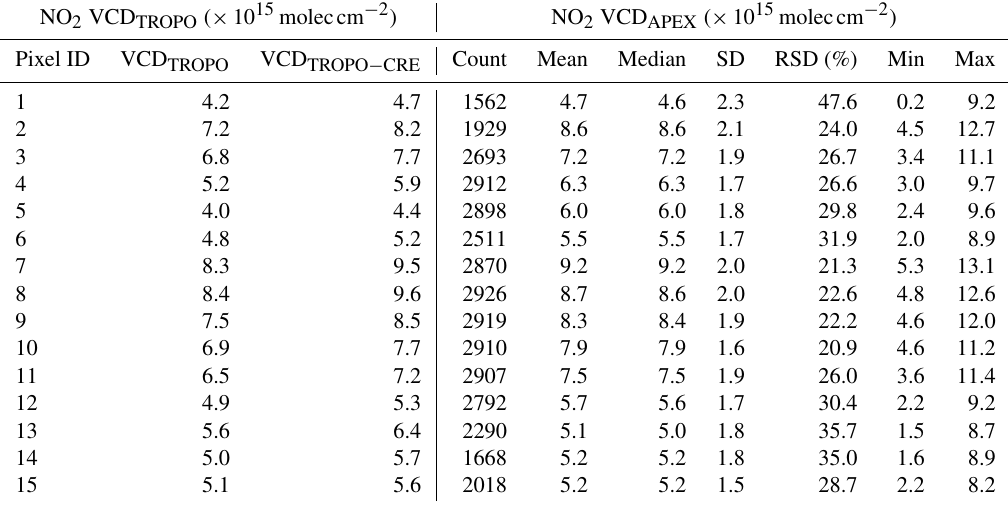
Table A3. Tropospheric NO 2 VCD statistics for coincident TROPOMI and APEX pixels for Flight no. 3, orbit 08840.